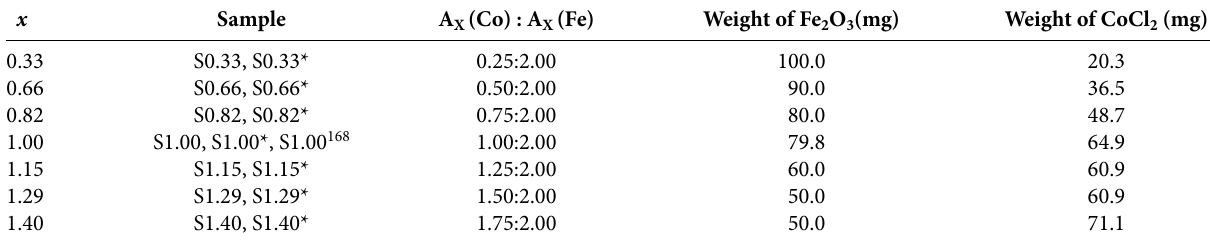
Table 1. List of samples, cobalt and iron atomic ratios and the quantities of cobalt chloride and hematite used for the synthesis. The nominal amount of Co in the formula Co x Fe 3-x O 4 is denoted by x. The samples prepared with radioactive 57 Co are labelled with *. x